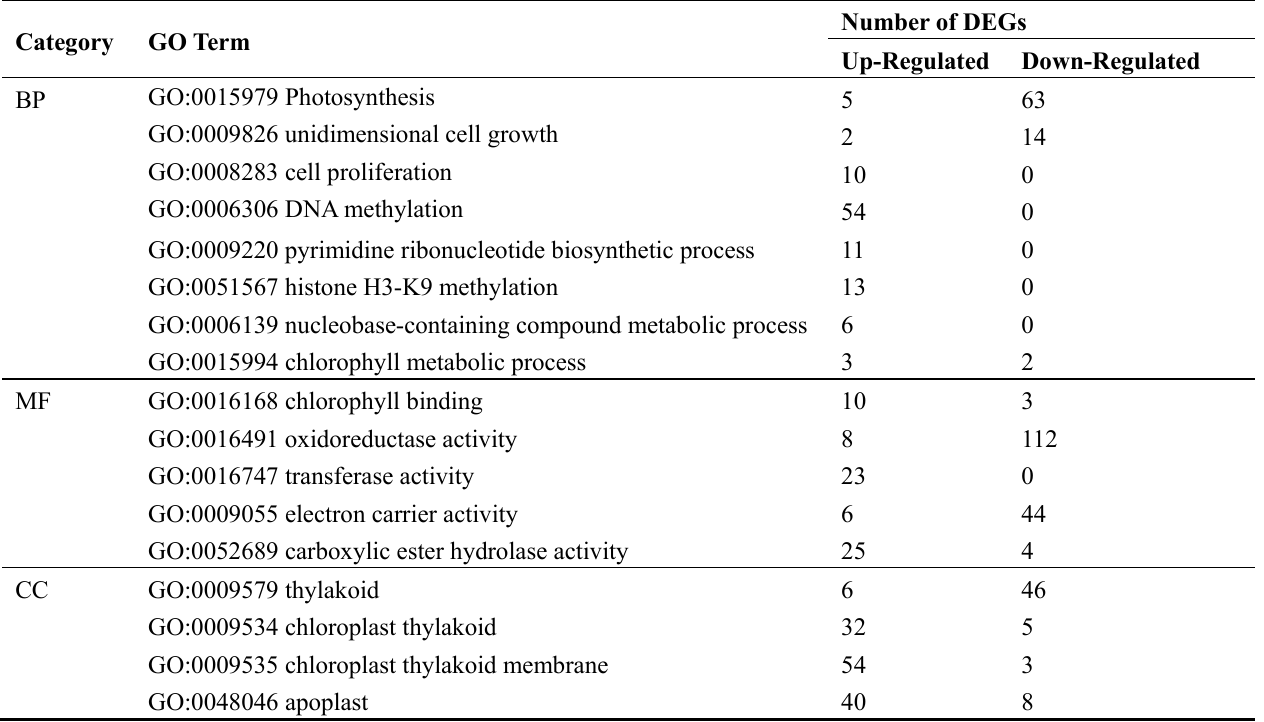
Table 2. Functional annotation of non-additive DEGs between high-growth allotriploid Populus progeny genotypes (PMR-H) and their parents based on GO